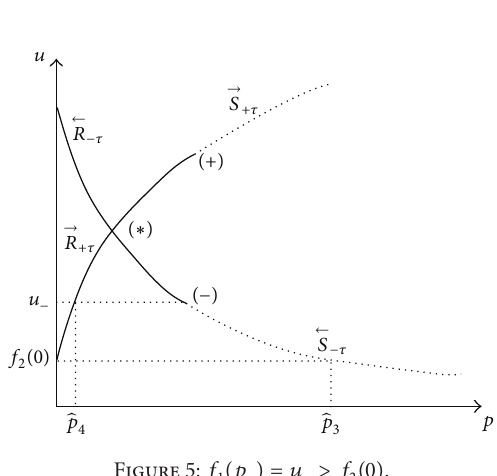
Figure 5: 𝑓 1 (𝑝 − ) = 𝑢 − > 𝑓 2 (0) .